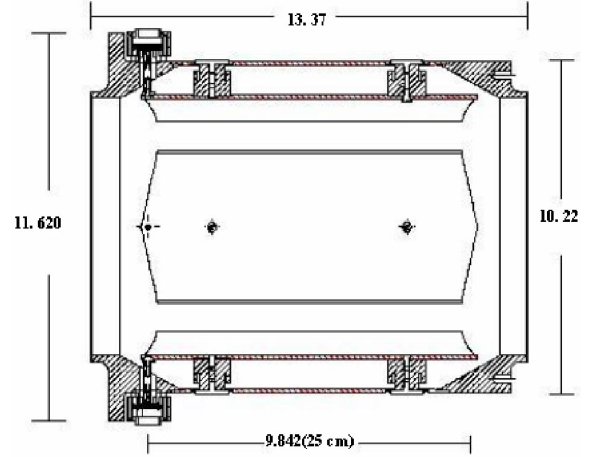
FIG. 1. (Color) Collection of stripped electrons during the injection of the H (cid:1) beam at the SNS ring. FIG. 2. (Color) Schematics of the floating-ground BPM de- signed for the SNS accumulator ring. A voltage of about 1000 V can be applied to clear the electron cloud.